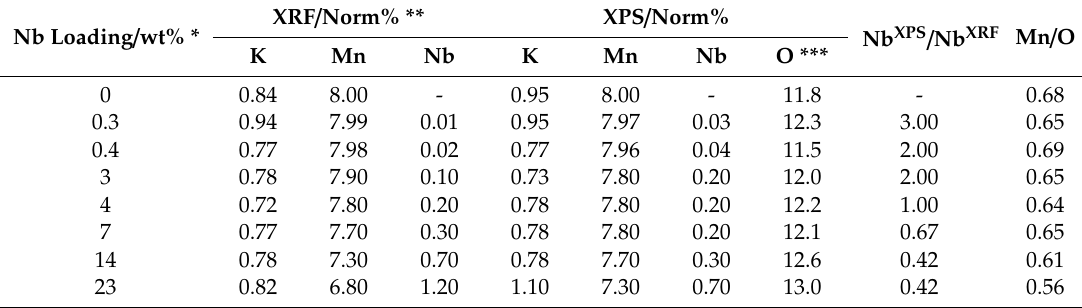
Table 3. Surface (XPS) and bulk (XRF) composition of investigated